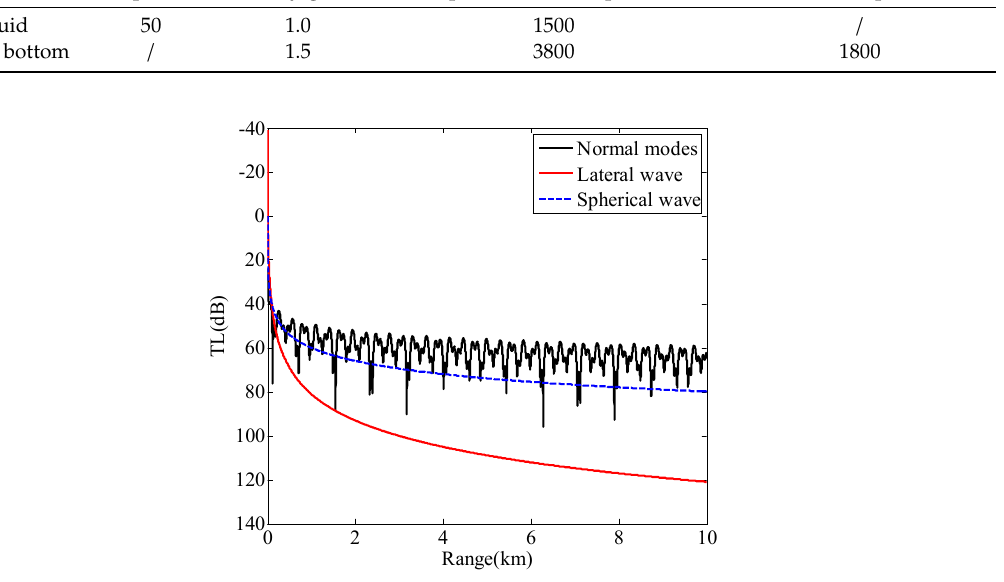
Figure 2. Transmission losses (TLs) of normal modes (black line), the lateral wave (red line), and the spherical wave (blue dashed line).